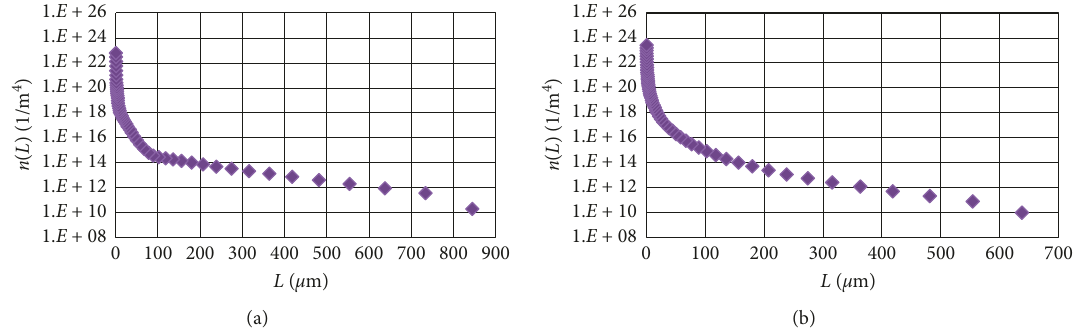
Figure 11: Population density n